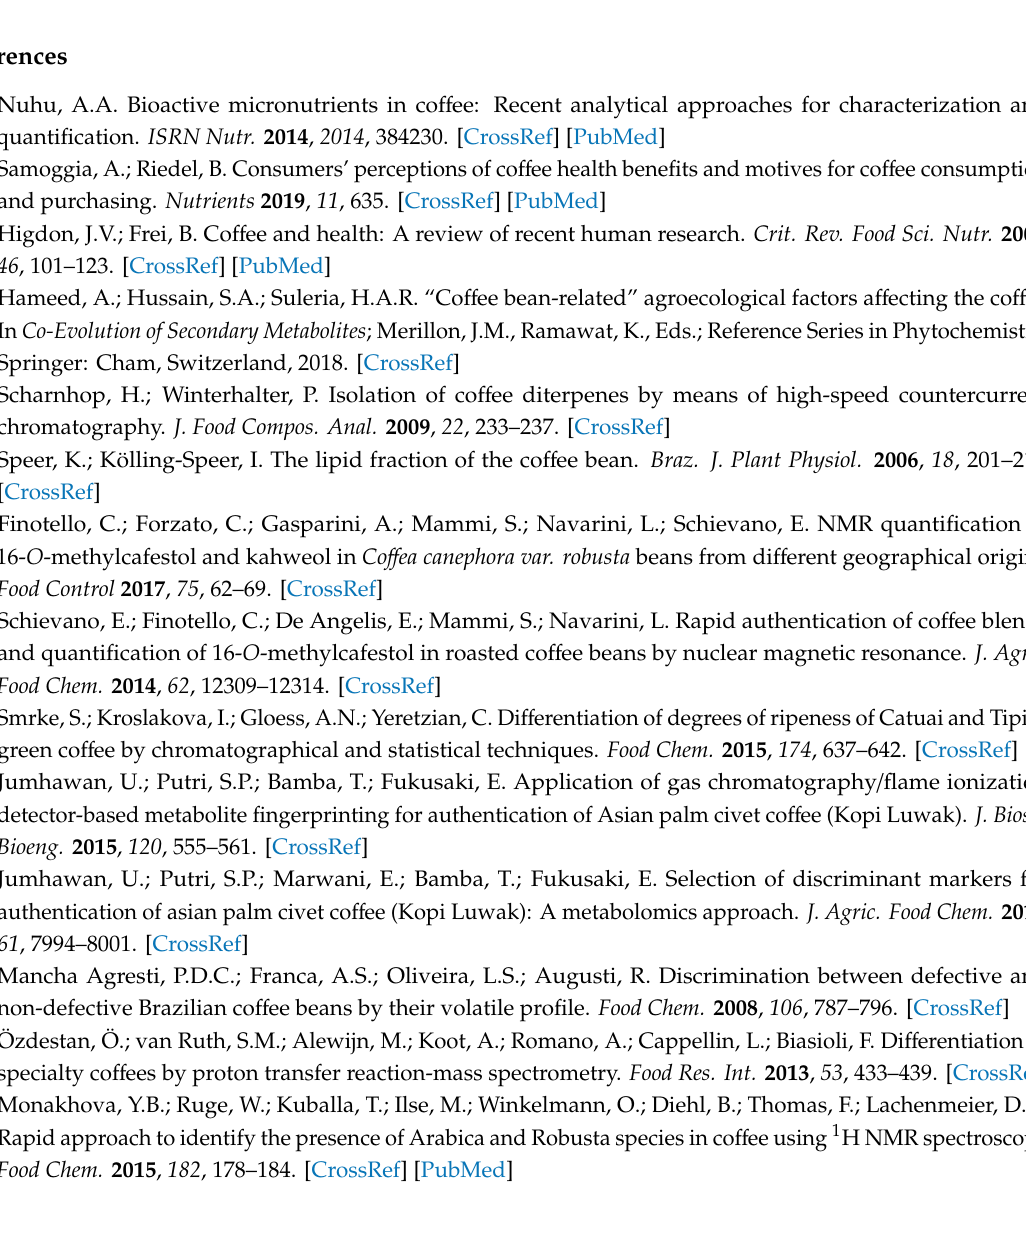
Table S1: Raw results of method validation for co ff ee using a factorial experimental design; Figure S1: Linearity determination of target